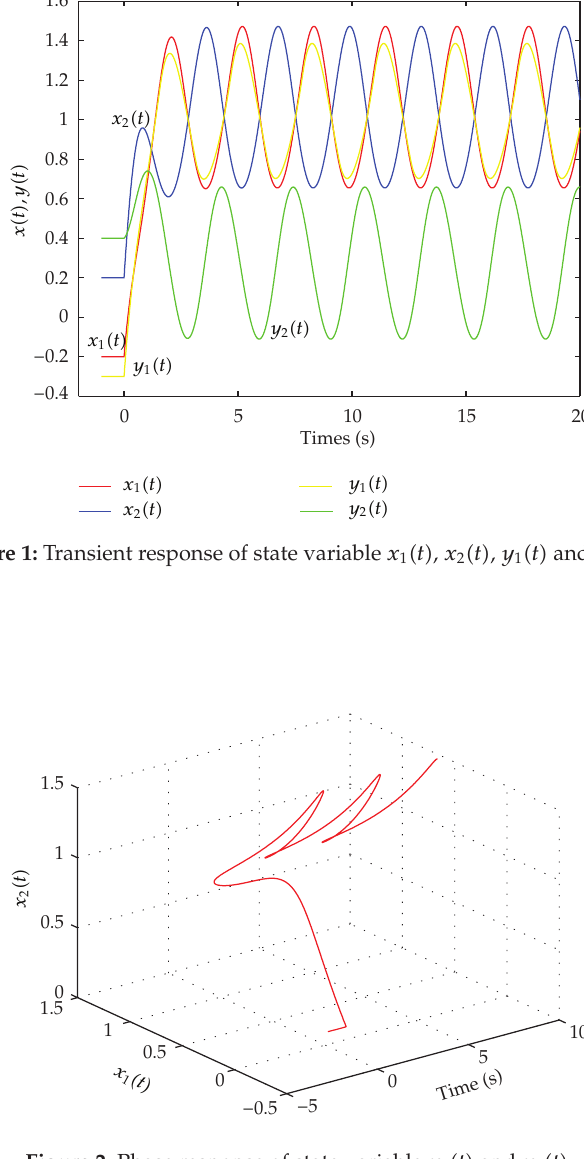
Figure 2: Phase response of state variable x 1 (cid:6) t (cid:7) and x 2 (cid:6) t (cid:7)